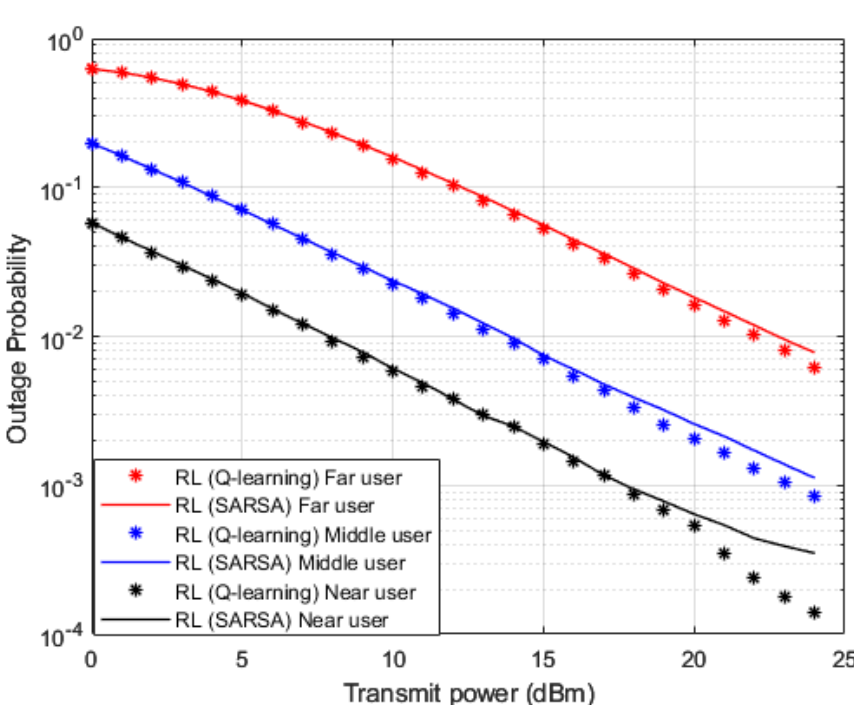
Figure 10. Outage Prob. vs. power ( Q -learning, SARSA).